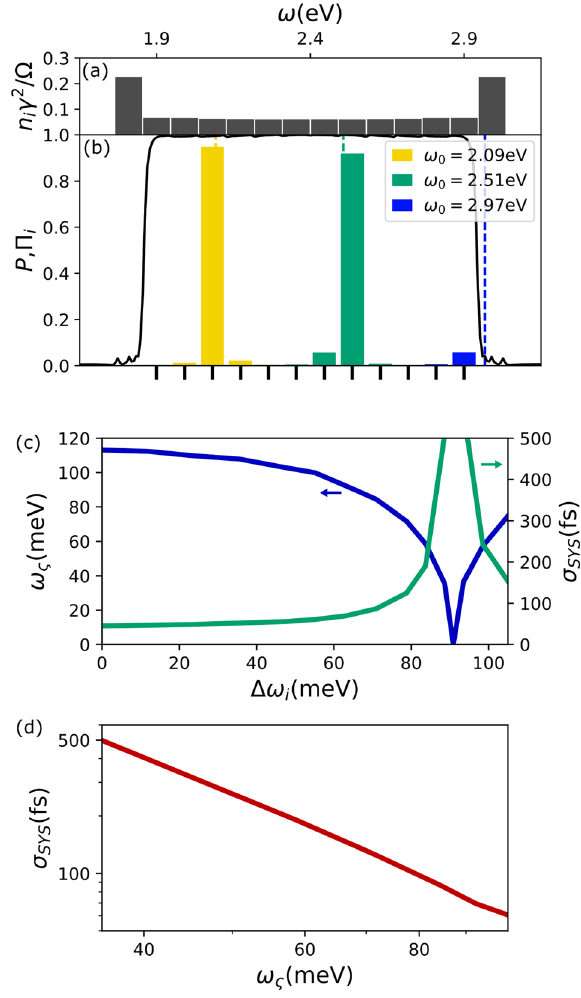
Fig. 4 Simultaneous high performance across metrics. a , b Performance of thesystem with the absorption of each subsystem elements uniformly spread over a range of 88.6meV, re fl ected in the width of the grey bars in a . In b the response for photons of three differencies ω 0 is shown, indicating very narrow frequency resolution while maintaining high ef fi ciency. c σ SYS and ω ς that result from the slowest Γ 2 that maintains greater than 99% ef fi ciency for a given Δ ω i . d σ SYS plotted against ω ς from b on a log/log